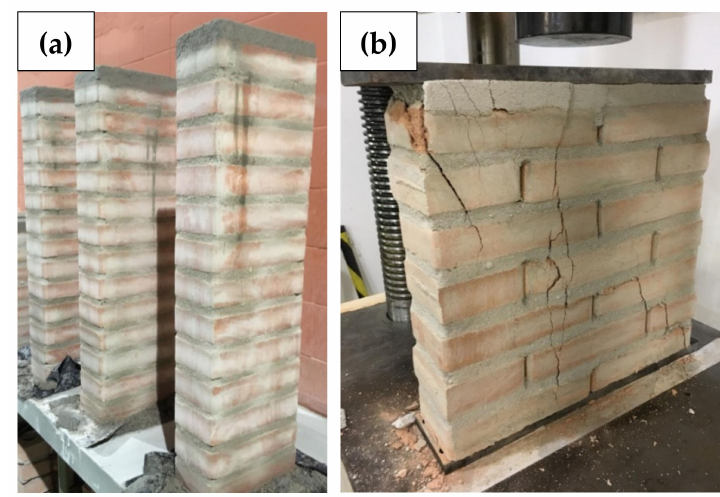
Figure 8. ( a ) Specimens for axial compression tests (fully reinforced small columns); ( b ) Axial compression test carried on a 50 cm length wallet with one reinforced hole